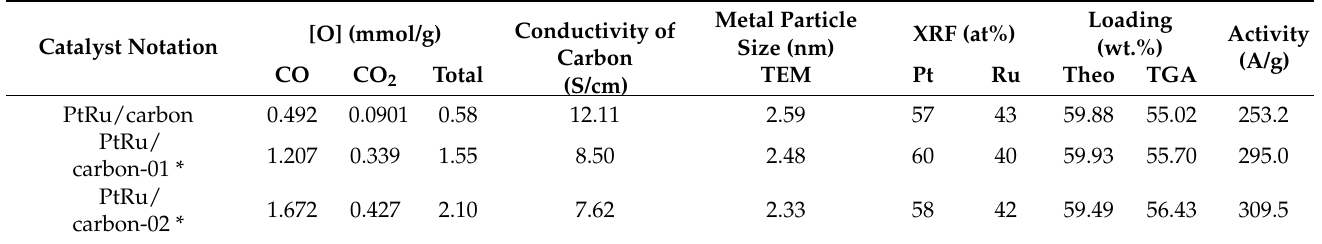
Table 6. Effects of carbon black modified with various amounts of H 2 O 2 on the activity of the catalysts.